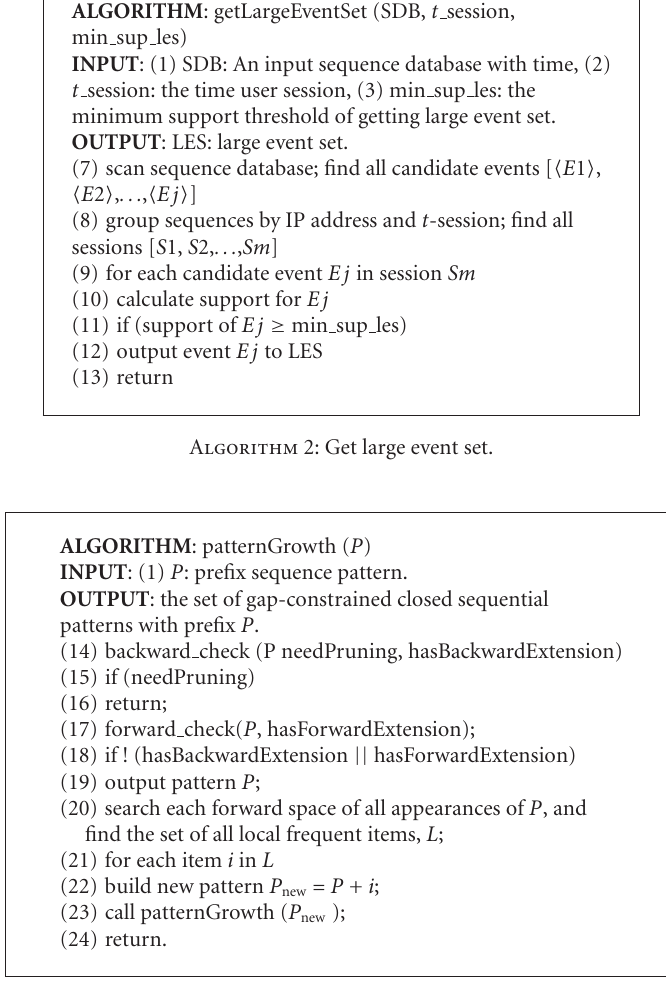
Algorithm 3: Generate closed sequential patterns.